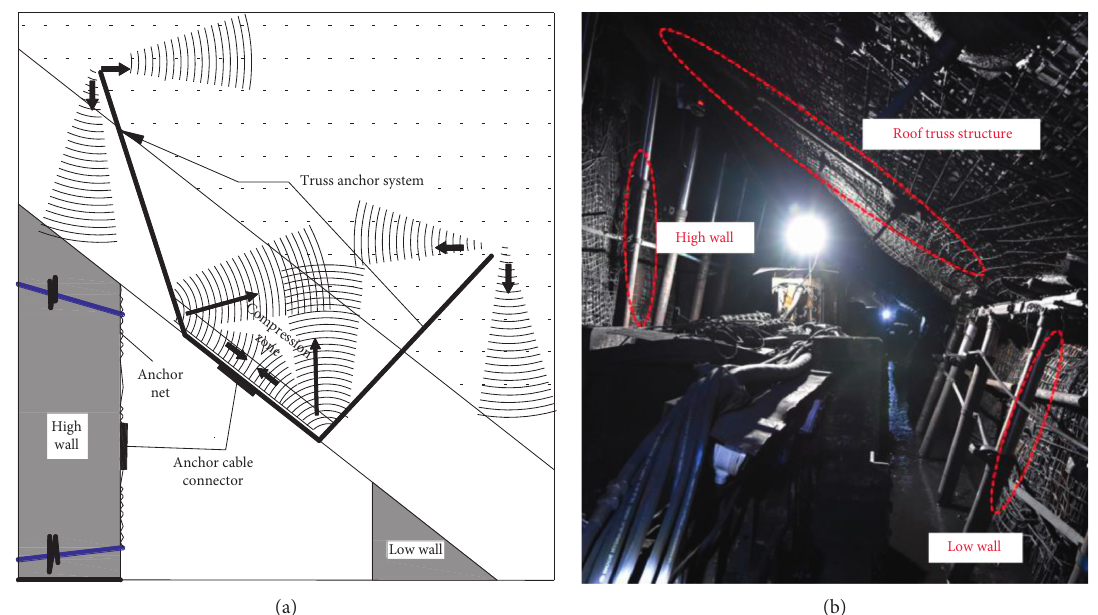
Figure 11: Stress diagram at the joint truss structure and field